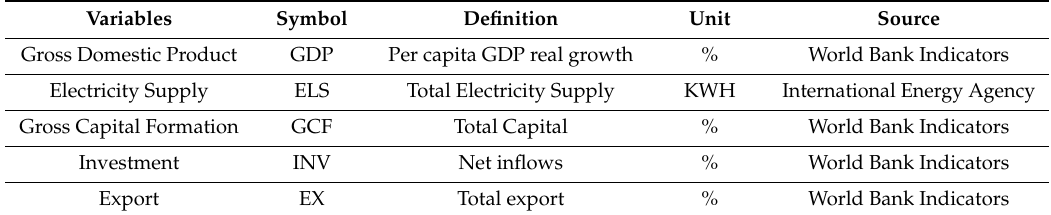
Table 2. Variables and their sources of